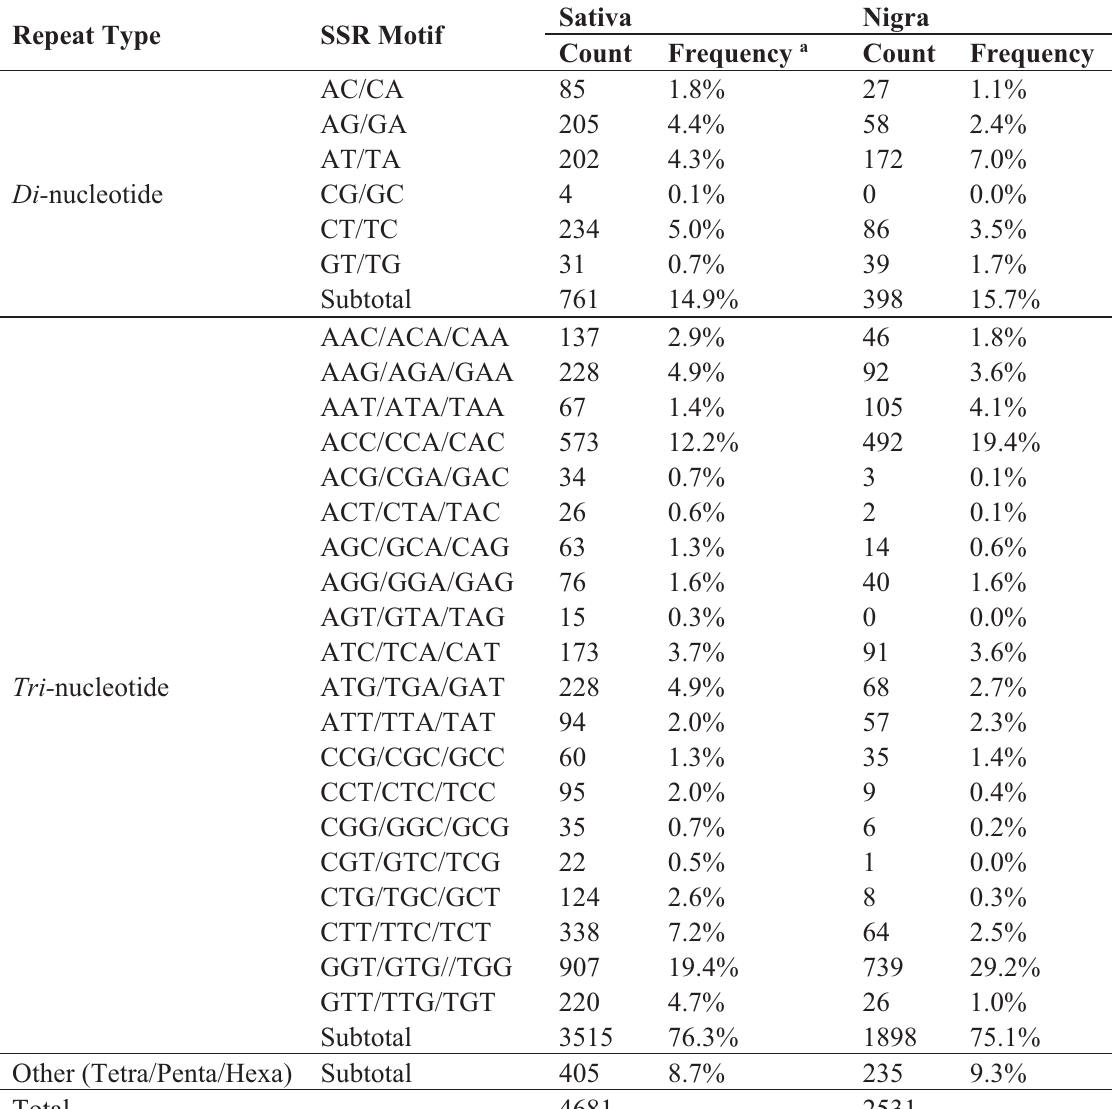
Table 3. The distributions of simple sequence repeats (SSRs) identified from the Vicia sativa nigra and sativa